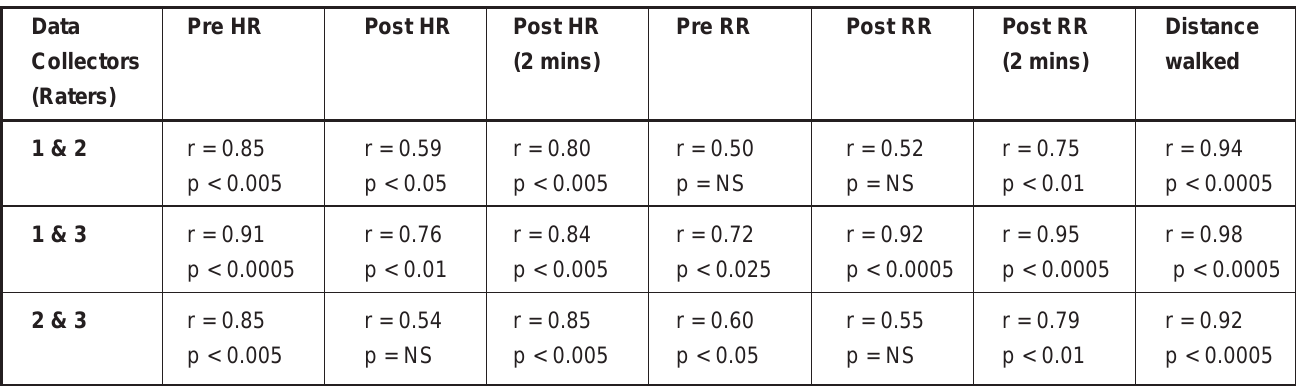
Table 1: Pearson product moment correlation coefficient results for 6-minute walk test – week 1 (df =